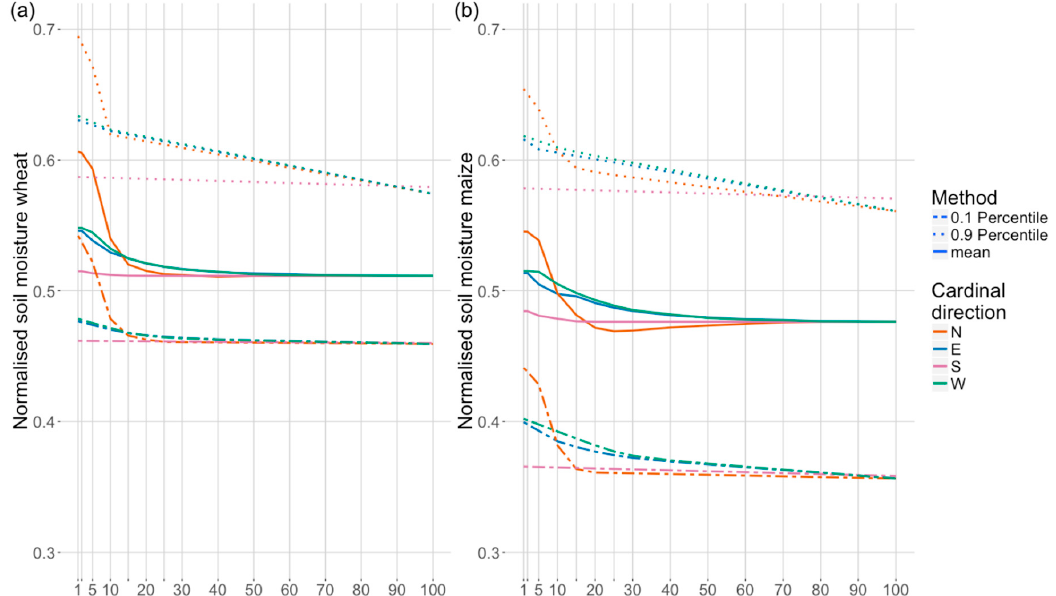
Figure 4. Simulated average daily soil moisture for wheat ( a ) and maize ( b ), with respect to the distance to the zero line, and the cardinal direction of a virtual forest matrix shading the adjacent arable land. The solid line represents the mean and the dashed lines represent the 0.1 and 0.9 percentiles.